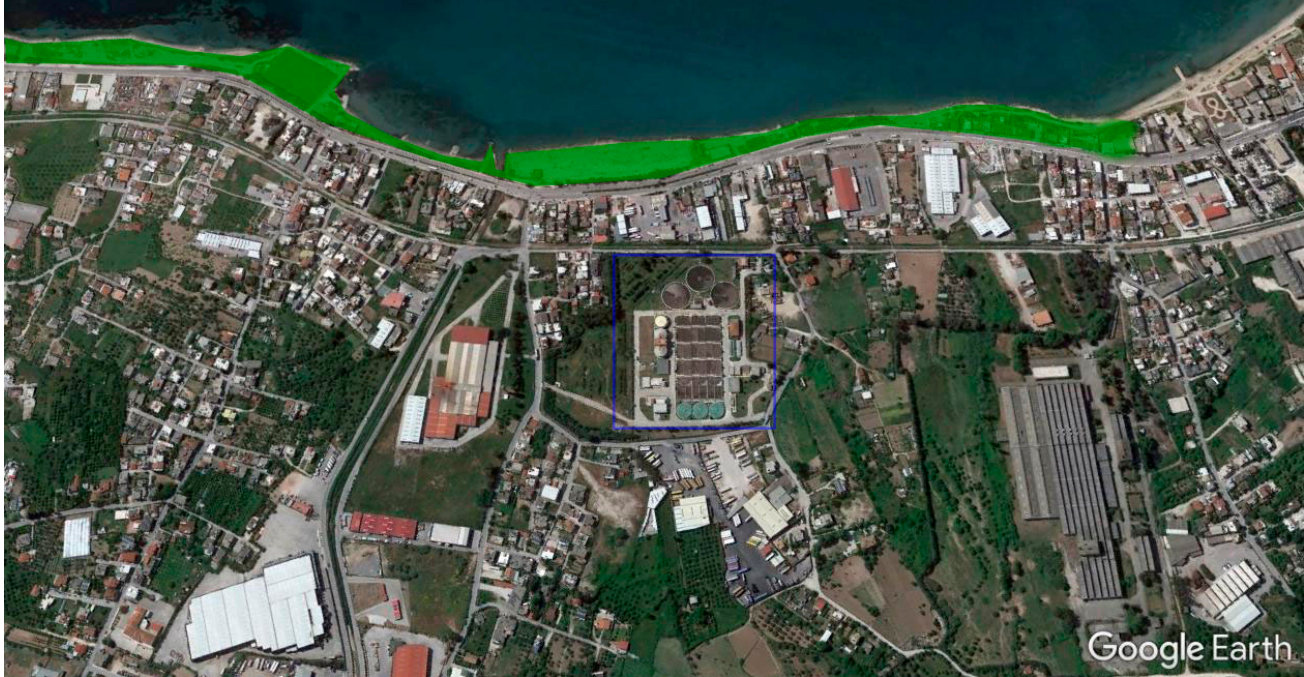
Figure 5. Proposed reuse application (urban use, irrigation of municipal park marked with green color) for the reclaimed water through the membrane filtration of Patras’ sewage treatment plant (marked with blue color) effluent.